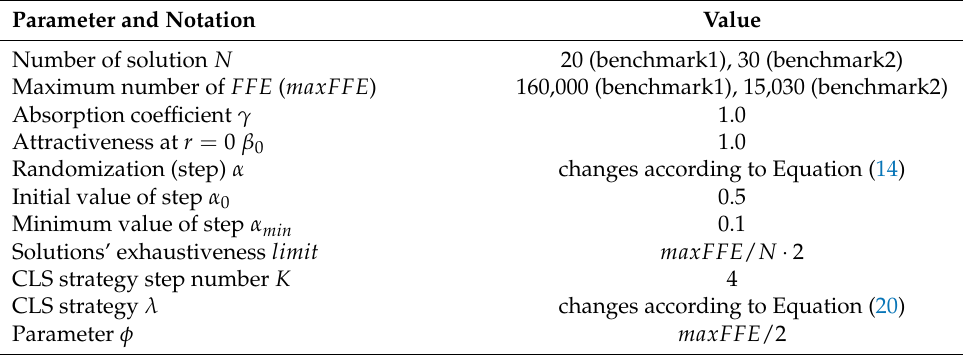
Table 1. Setup of CFAEE control